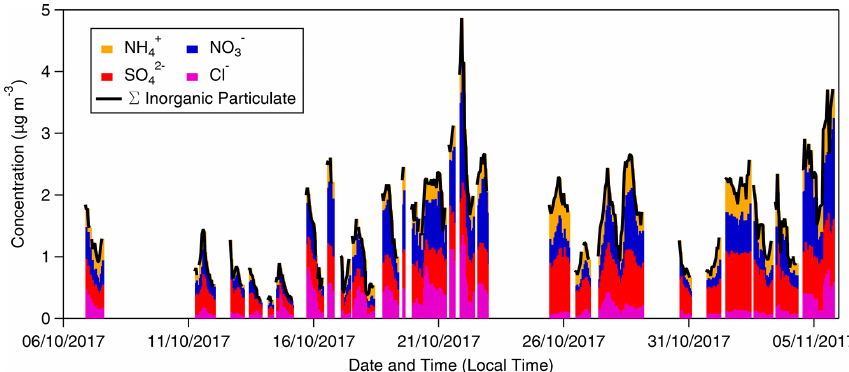
Figure 13. Summed mass and speciation of inorganic particulate recorded by GRAEGOR at 80m throughout period of